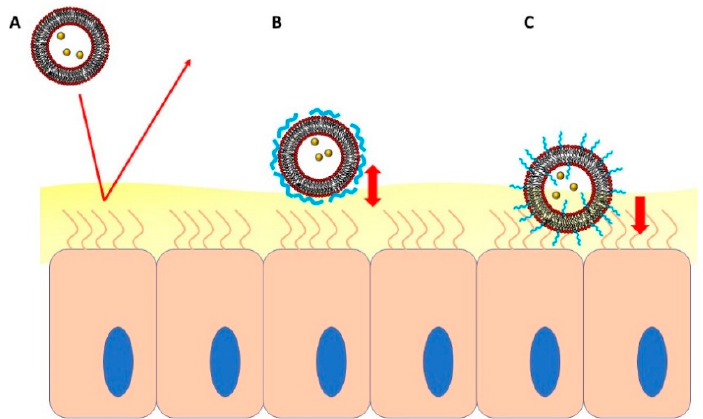
Figure 5. Scheme of a generic tissue formed by several cells (in orange with blue nuclei) covered by mucus (in yellow). ( A ) Conventional liposome unable to cross the mucosal barrier; ( B ) liposome covered by polymer, increasing the mucoadhesive properties of the vesicle; ( C ) liposome decorated with polymer conferring mucopenetrating properties to the vesicle.